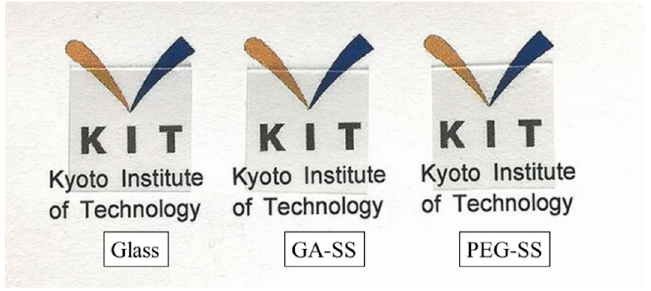
Figure A1. A photo of specimens.